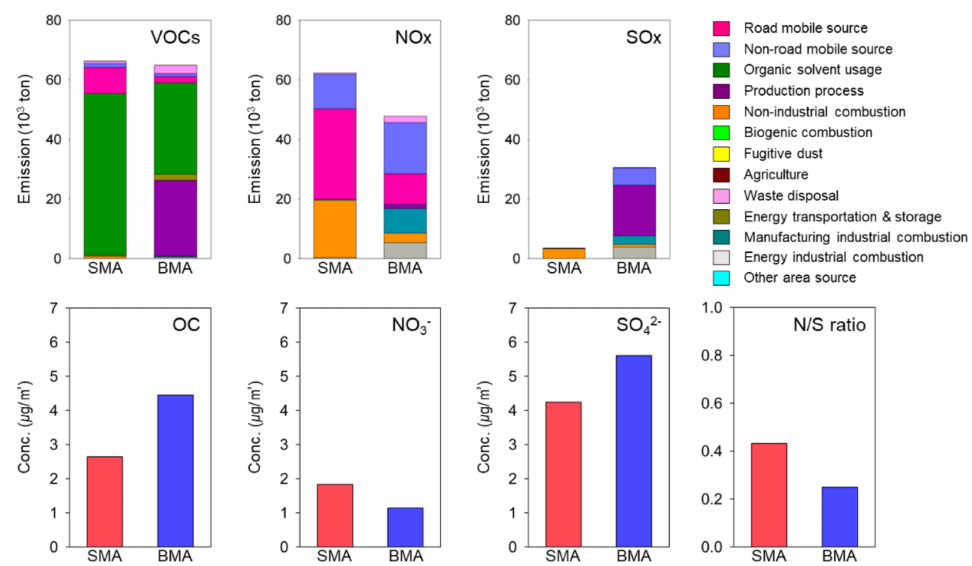
Figure 2. Emissions (annual), summertime (June–August) ground observations, and N/S ratios in SMA and